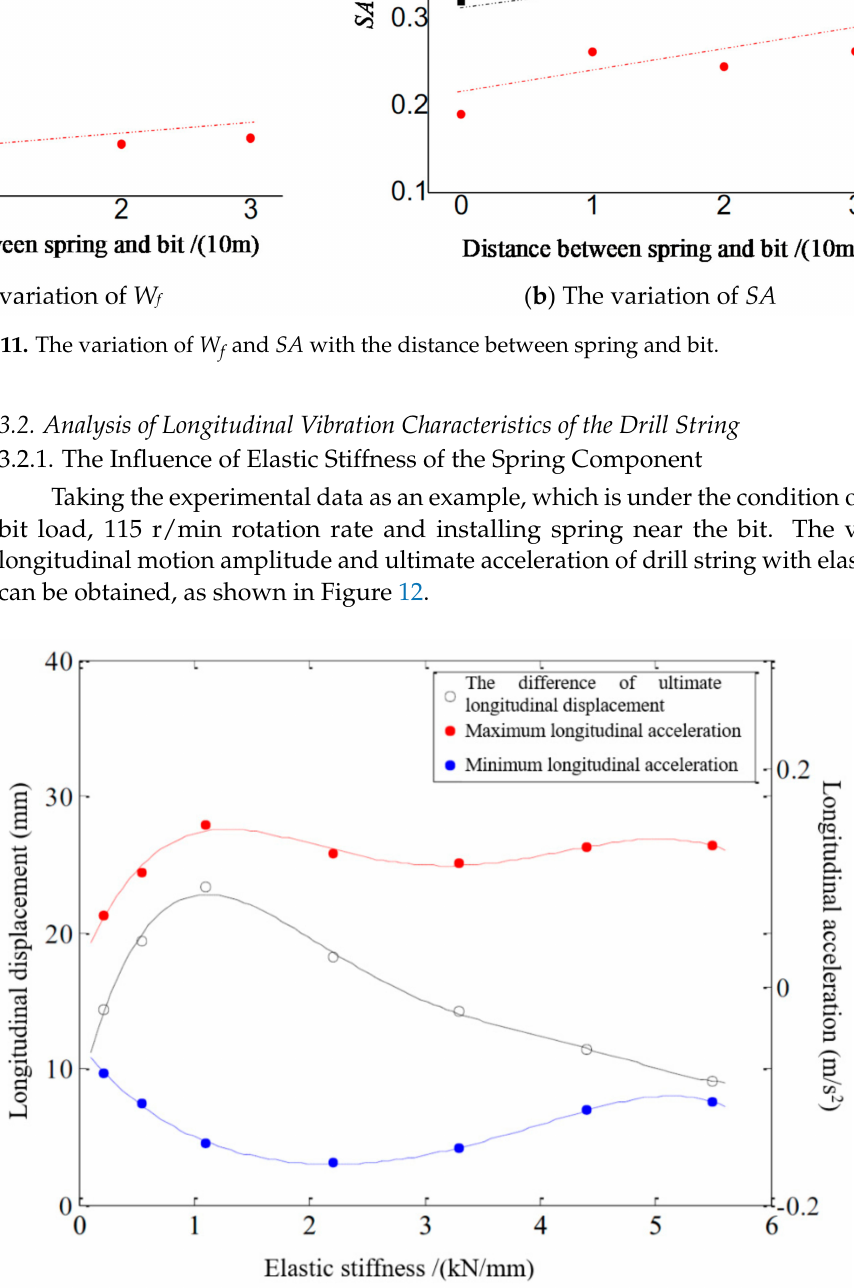
Figure 12. The variation of longitudinal motion amplitude and ultimate acceleration of drill string with elastic